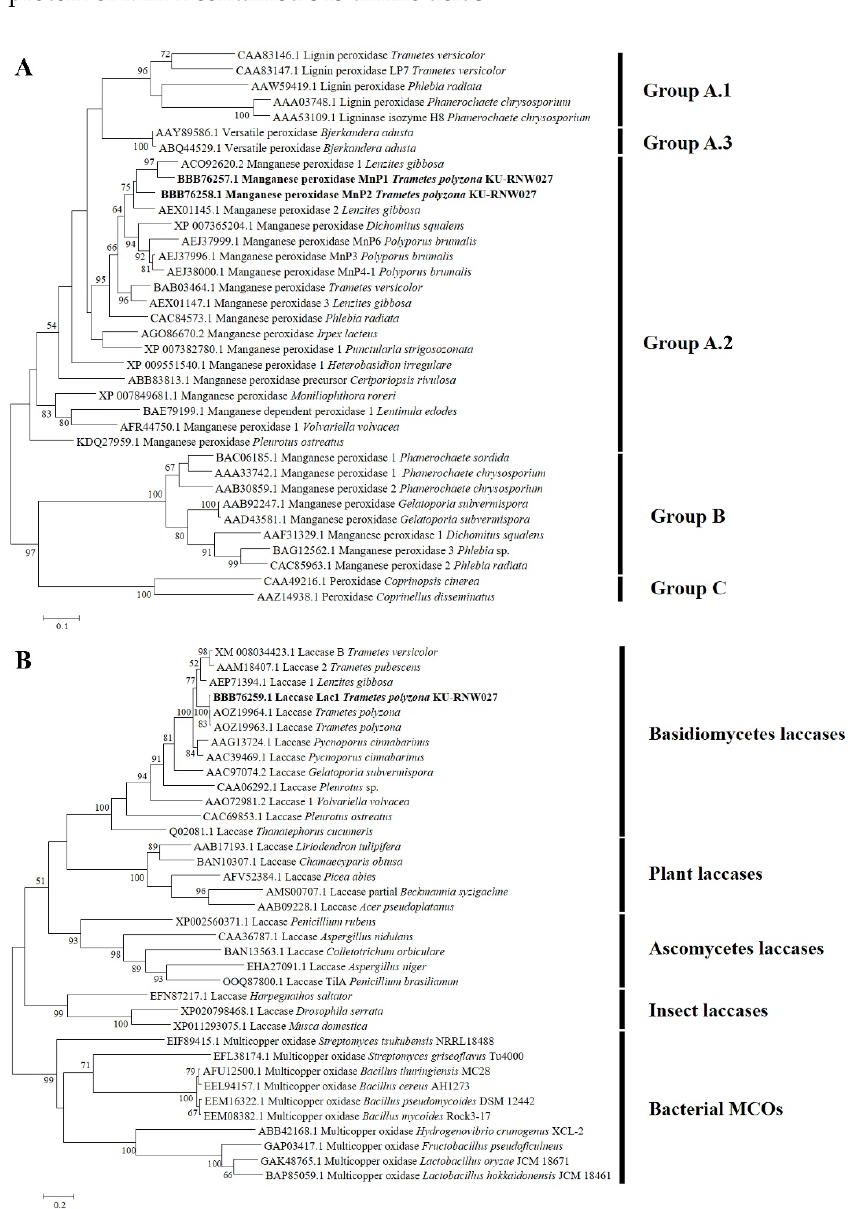
Figure 1. ( A ) Phylogenetic tree of class II fungal secreted heme peroxidases and ( B ) multiple copper oxidases. Maximum likelihood trees of 34 complete ORF translated amino acids for class II fungal secreted heme peroxidase and 35 complete ORF translated amino acids for multiple copper oxidases were constructed using Mega version 6.0. Confidence values above 50% obtained from 1000 bootstrap replications are indicated at branch nodes. The scale bar indicates the number of amino acid substitutions per site.